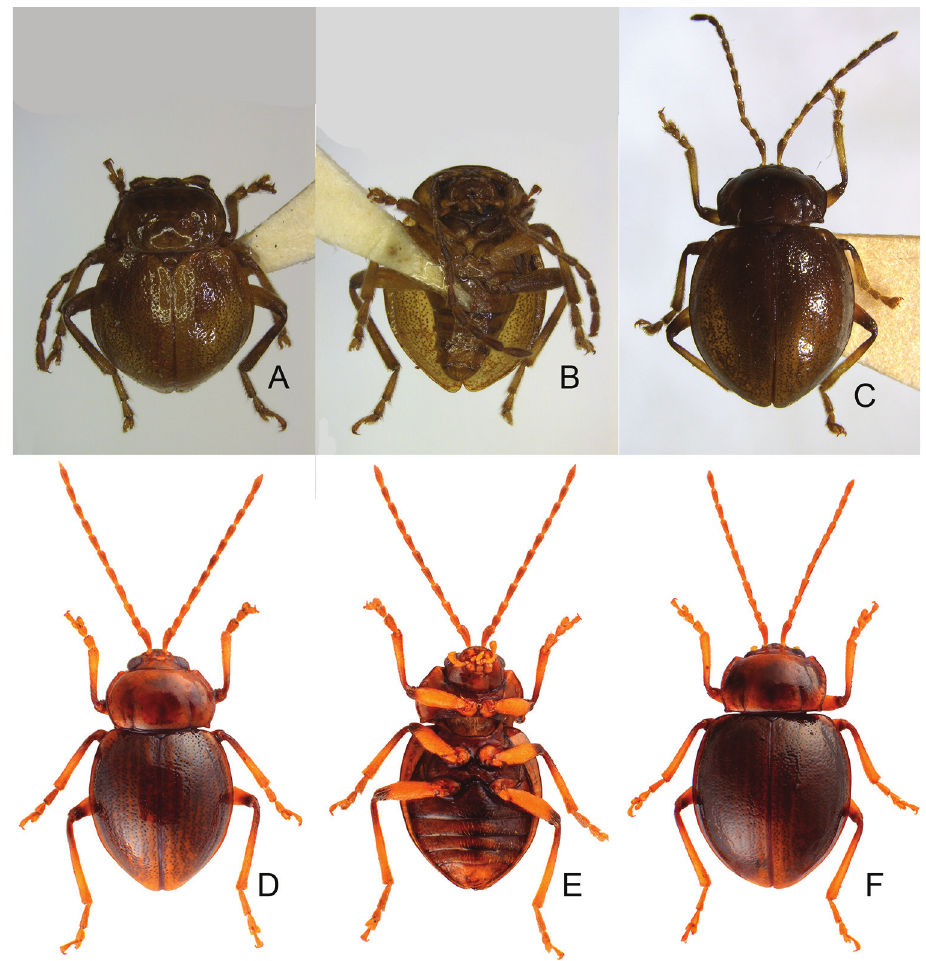
Figure 3. Habitus of Taiwanoshaira chujoi comb. nov. A male, paratype, from Alishan ( 阿里山 ), dorsal view B same, ventral view C female, paratype, from Tapan ( 達邦 ), dorsal view D male, from Bilu Divine Tree ( 碧綠神木 ), dorsal view E same, ventral view F female, from Bilu Divine Tree ( 碧綠神木 ), dorsal